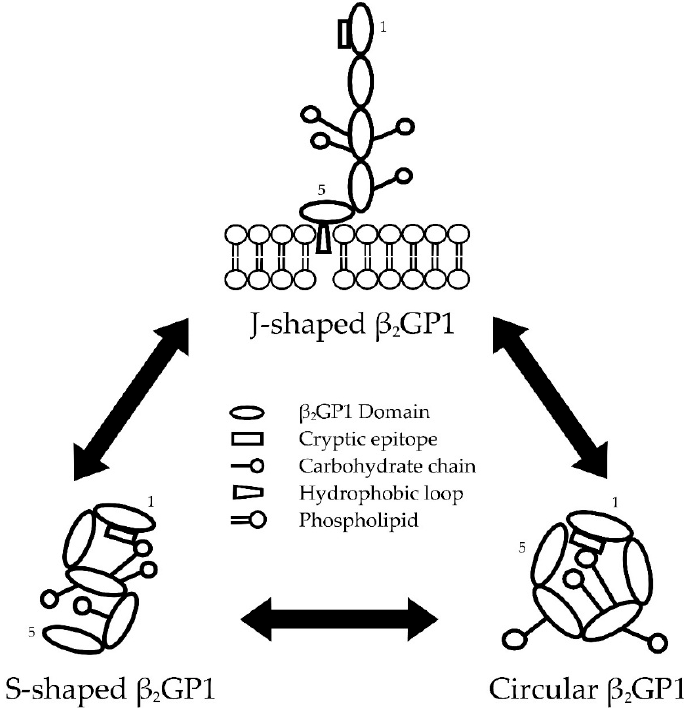
Figure 1 . The interchangeable conformations of beta-2-glycoprotein 1 ( β 2 GP1). β 2 GP1 is able to transform between three conformations: J-shaped, S-shaped, and circular β 2 GP1. Cryptic epitopes in S-shaped are shielded by carbohydrate chains [43]. Whereas, cryptic epitopes in circular β 2 GP1 are shielded by both carbohydrate chains and domain V [41,44]. Binding of domain V positively charged amino acids and hydrophobic loop to phospholipid membrane breaks the shield on domain I [41]. This exposes the cryptic epitope and allows the binding of clinically significant anti-domain-I- β 2 GP1 antibody.